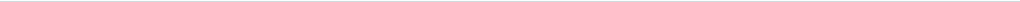
Figure 2: Frequency and type of local and systemic AEFI in different clinical settings. (A) The overall frequency of reported AEFI is displayed by reaction type. LR: local reaction; SR: systemic reaction; AEFI: adverse events following immunisation. (B) The frequency of immunisation visits associated with AEFI in the three clinical groups is displayed. Regular: routine vaccination check-up visits; HCW: healthcare workers; IMID: subjects with diagnosed immune-mediated inflammatory disease; LR only: reporting a local reaction only; SR only: reporting a systemic reaction only: combined LR/SR: subjects reporting at least one local and systemic symptom following the immunisation visit. Data include all visits with a valid reply to SMS-1 and, in the case of a reported AEFI, with a completed online